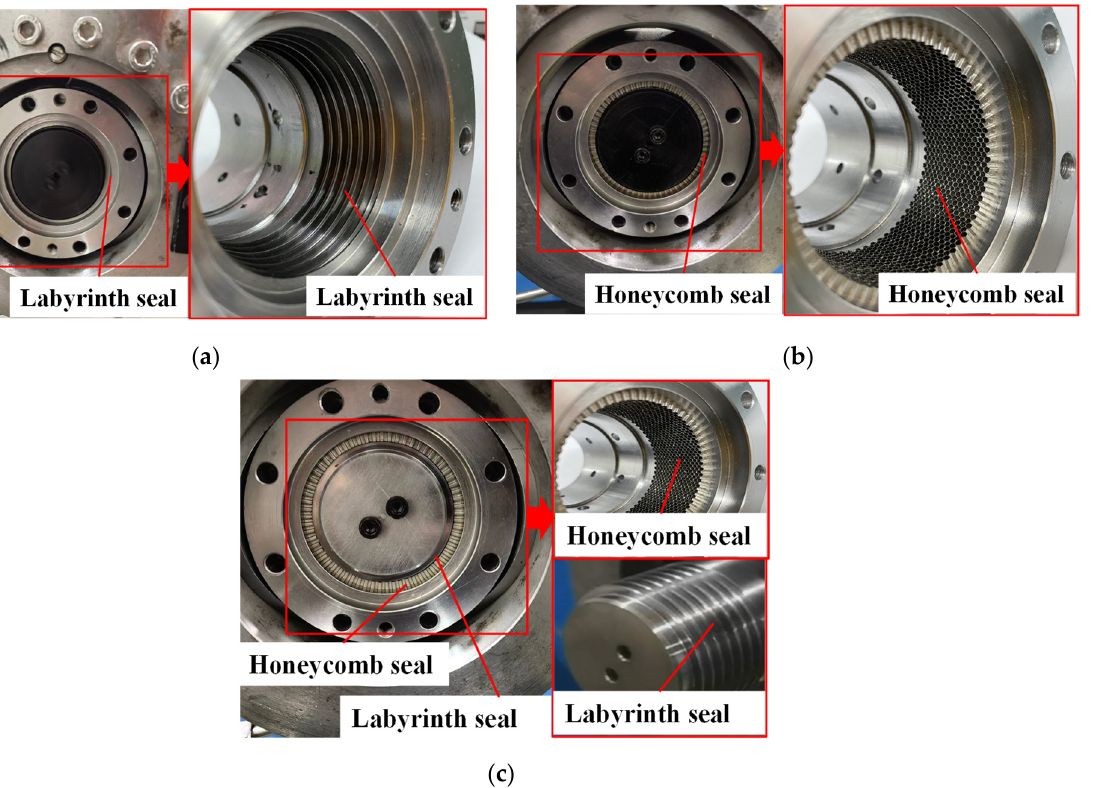
Figure 14. Physical picture of three types of seals. ( a ) Labyrinth seal; ( b ) honeycomb seal; ( c ) hybrid labyrinth–honeycomb seal.